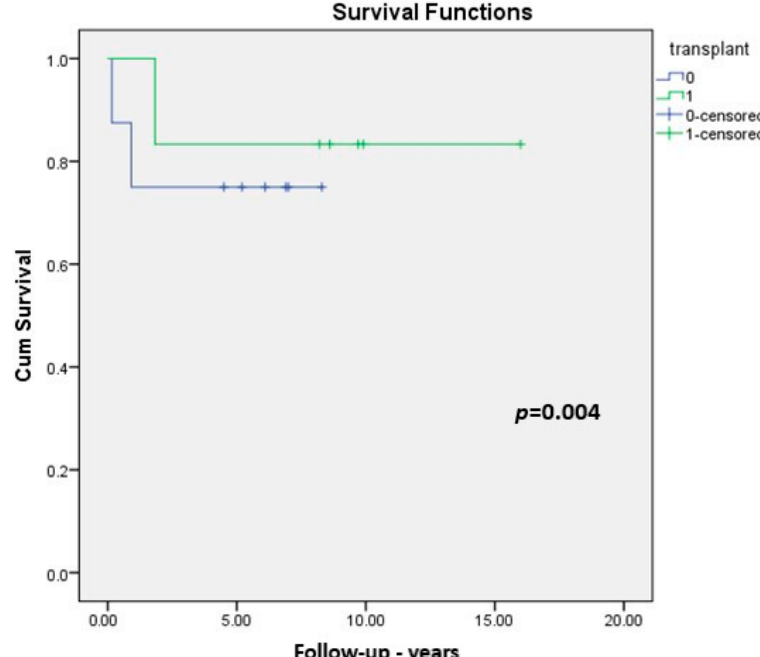
Figure 3. Survival for transplanted and native liver patients.